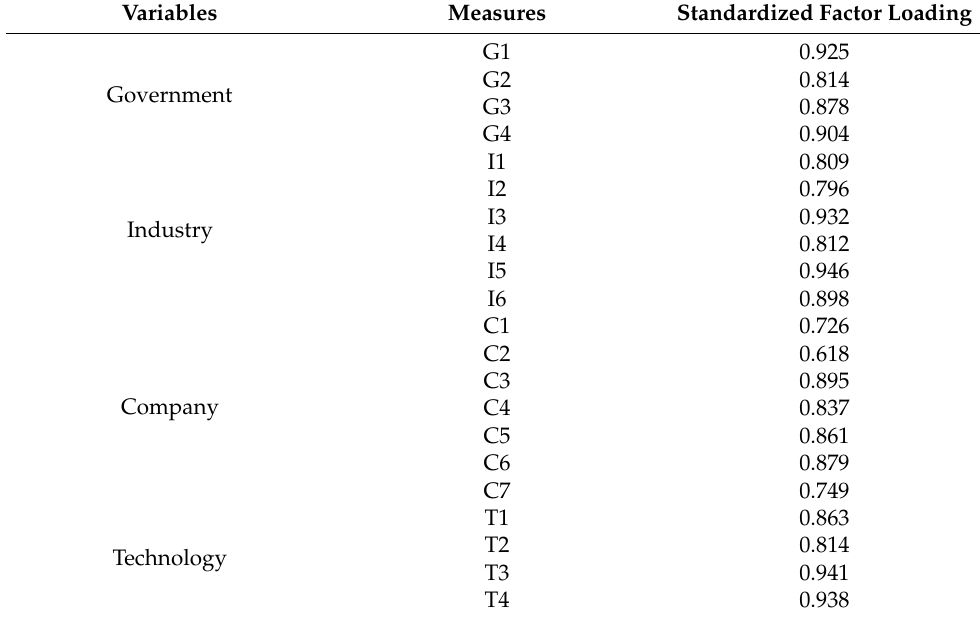
Table 7. Results of the measures.